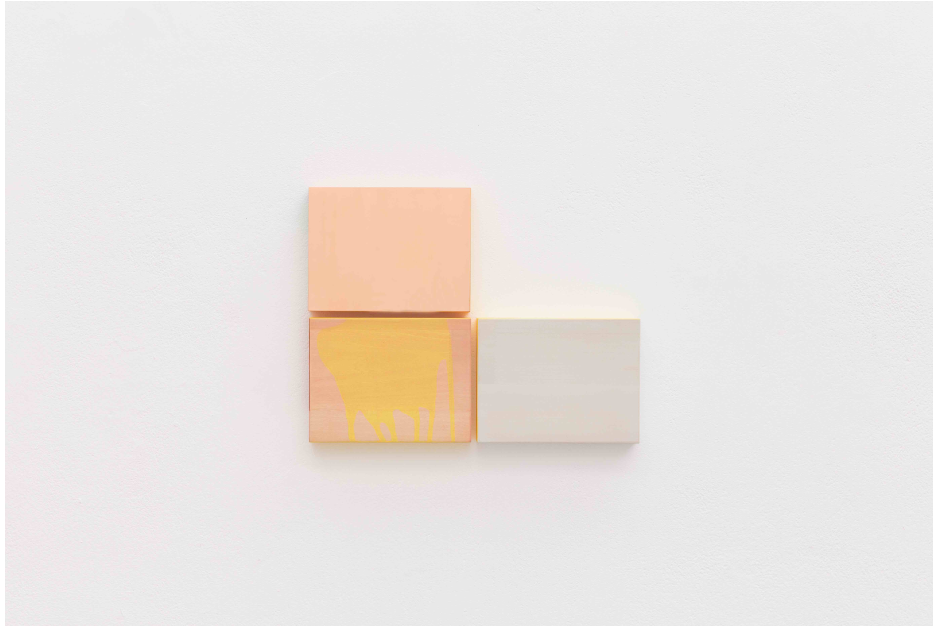
Figure 8: Jane Bustin, Yellow patch (arrangement) , 2016, Oil, acrylic, copper, wood. Triptych 30 x 40cm